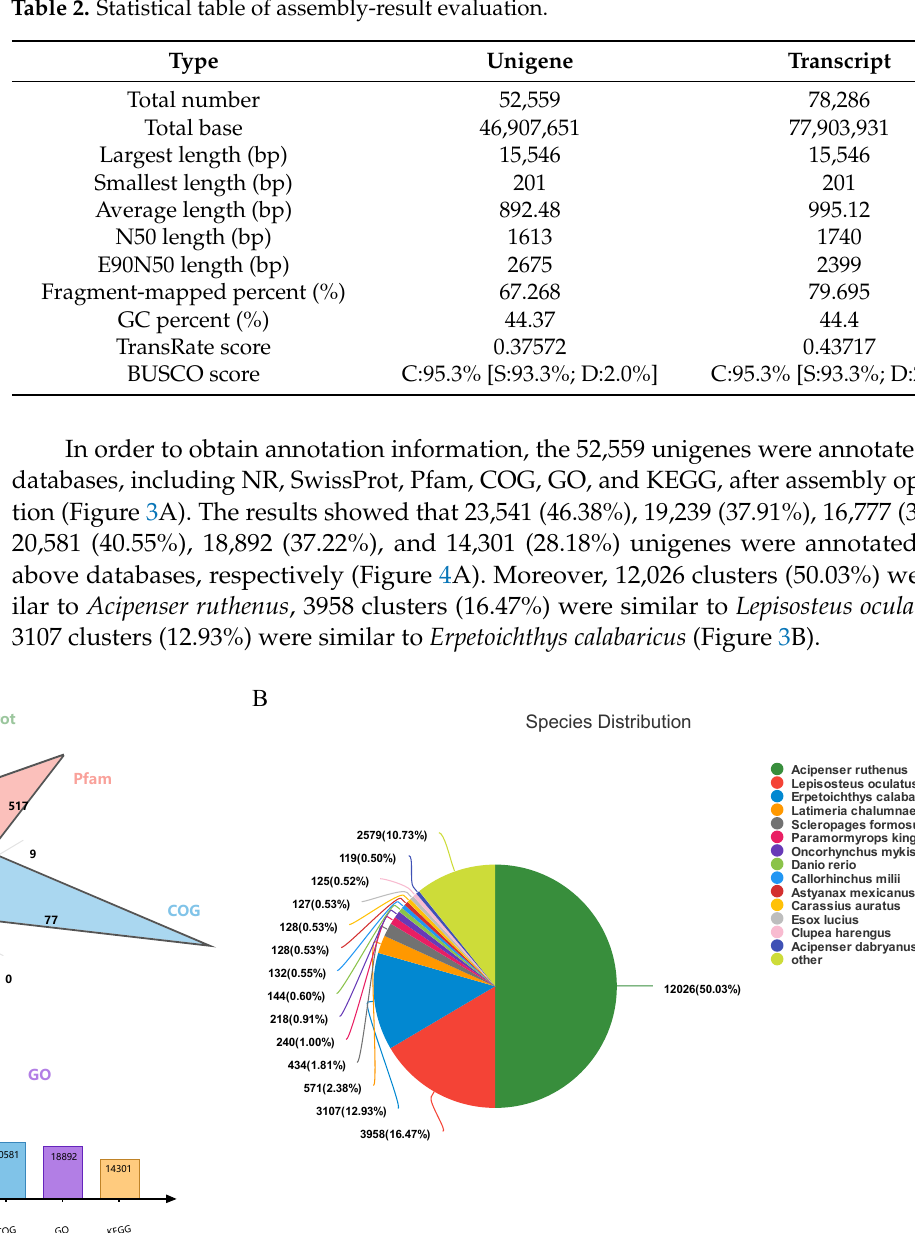
Table 2. Statistical table of assembly-result evaluation. Table 1. Formulation and nutritional composition of commercial feed.